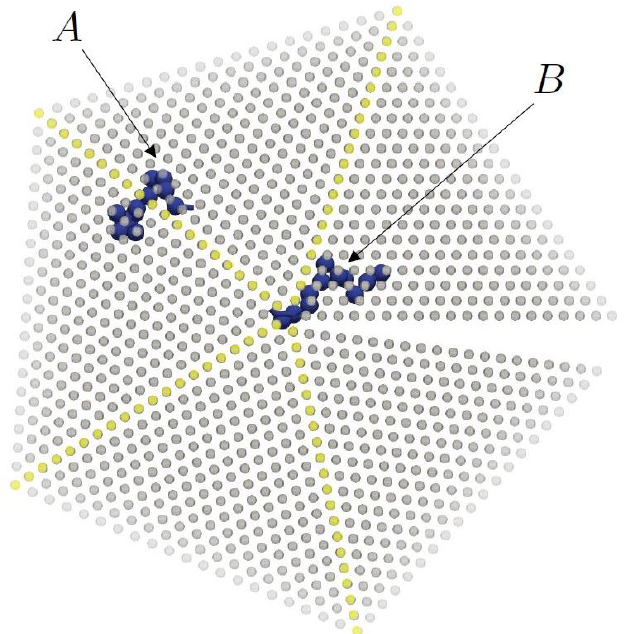
Figure 6. In a cyclic pentatwin (pentagonal bipyramid), chains that span the boundary between twin sectors (A) or that pass through the twin axis (B) lose configurational entropy with respect to those in a bulk, untwinned crystal, as explained in detail in [113]. The white (empty) horizontal wedge is the angular gap of 7.35 ◦ left when five equally sized tetrahedra are arranged cyclically around the twin axis (perpendicular to the paper in this